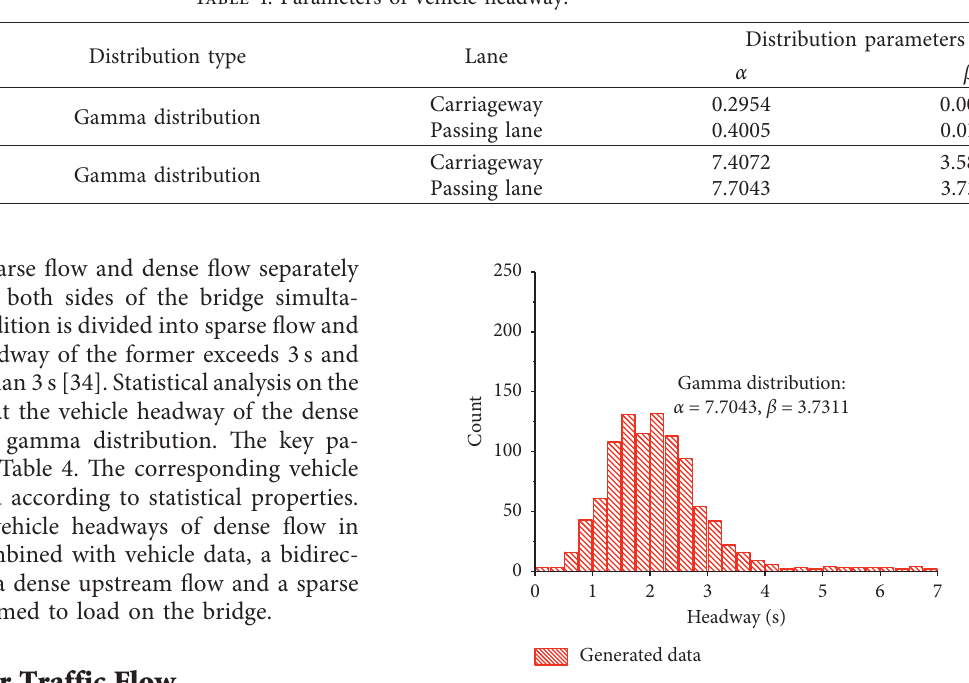
Figure 14: Flowchart of traffic flow generating. Table 4: Parameters of vehicle